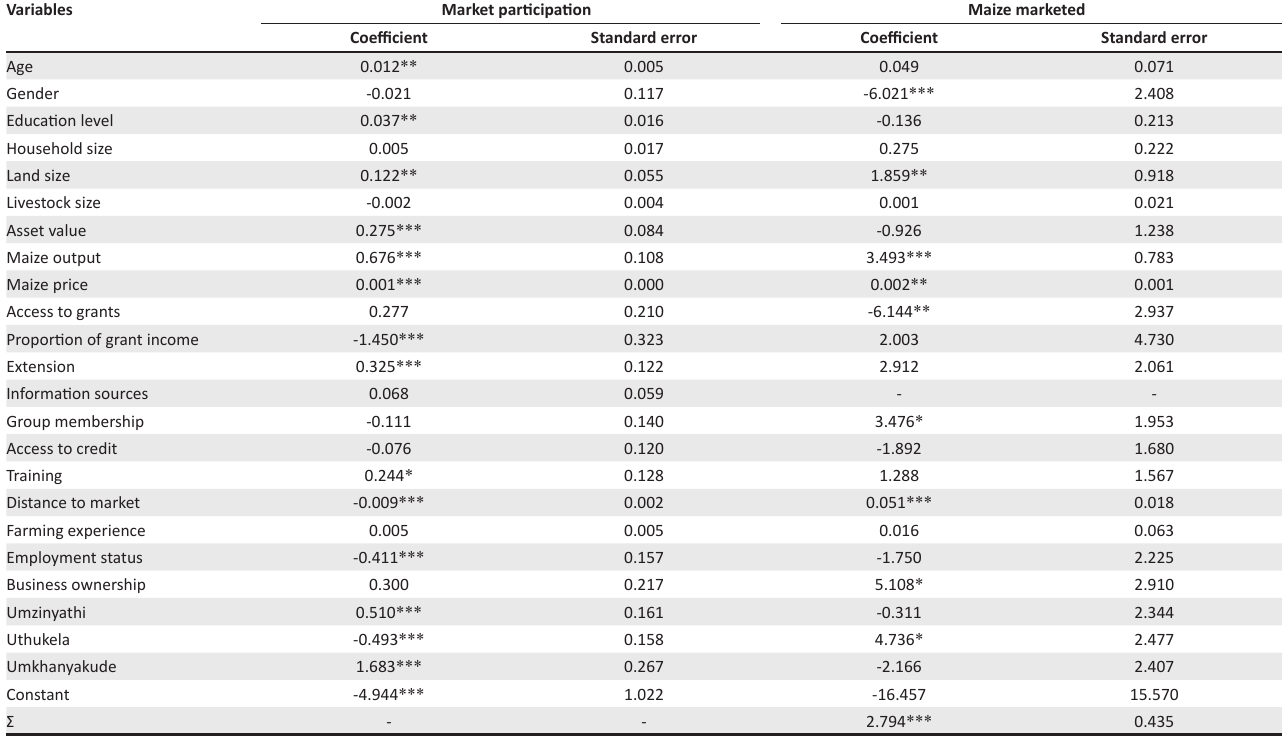
TABLE 3: The impact of social grants dependency on maize market participation: The double-hurdle model results ( N = 774).